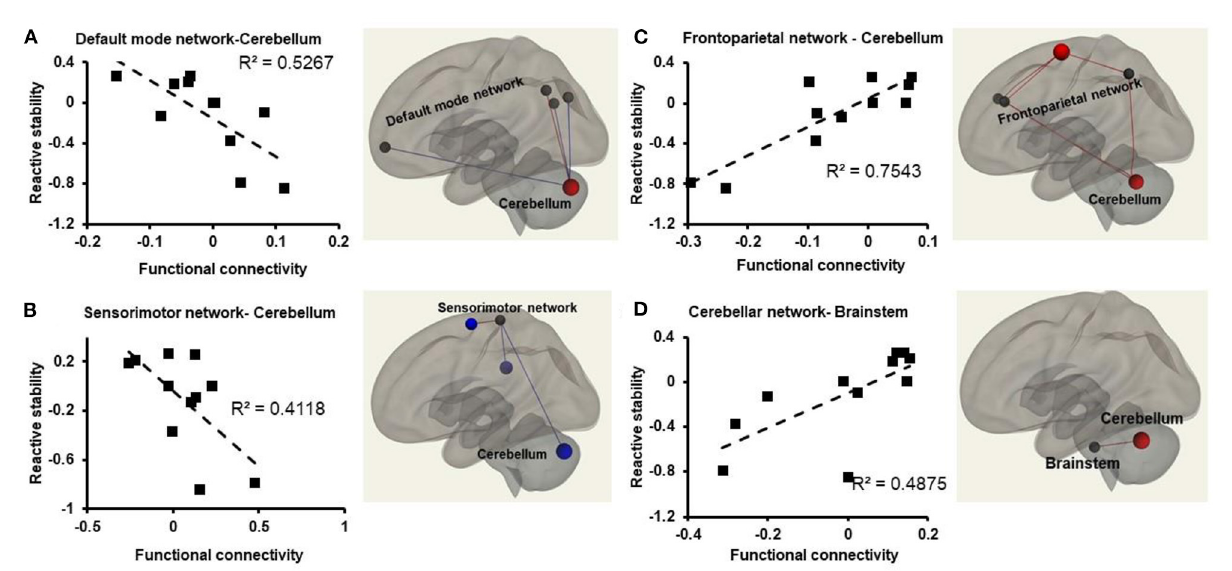
FIGURE3 Relationships between atlas-network (represented in z-scores on the x-axis) and reactive stability (represented on the y-axis) in older adults with mild cognitive impairment. Weakened connectivity in the brain is indicated via blue lines and increased functional connectivity with red lines. (A) Weakened functional connectivity between default mode network and the cerebellum in the brain such that older adults with mild cognitive impairment with higher reactive stability exhibited lower functional connectivity strength during resting state; (B) weakened functional connectivity observed between the sensorimotor network and the cerebellum in the brain such that older adults with mild cognitive impairment with higher reactive stability exhibited lower functional connectivity strength during resting state; (C) increased functional connectivity strength observed between the frontoparietal network and the cerebellum in the brain such that older adults with mild cognitive impairment with higher reactive stability exhibited higher functional connectivity strength during resting state; (D) increased functional connectivity strength observed between the cerebellar network and the brainstem in the brain such that older adults with mild cognitive impairment with higher reactive stability exhibited higher functional connectivity strength during resting